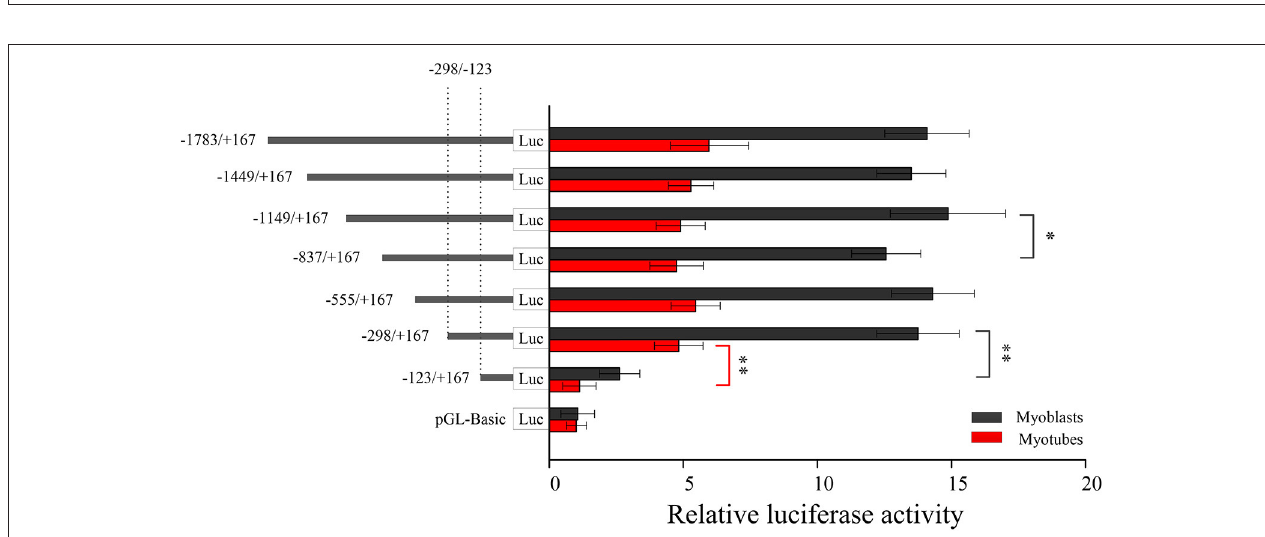
FIGURE 4 | Isolation and analysis of the functional proximal minimal promoter of LATS 1. A series of plasmids containing 5’ unidirectional deletions of the promoter region of the LATS 1 gene fused in-frame to the luciferase gene were transfected into myoblasts and myotube cells. The results are expressed as the means ± SD in arbitrary units based on the firefly/ Renilla luciferase activity in triplicate transfections. “*” p < 0.05 and “**” p < 0.01.